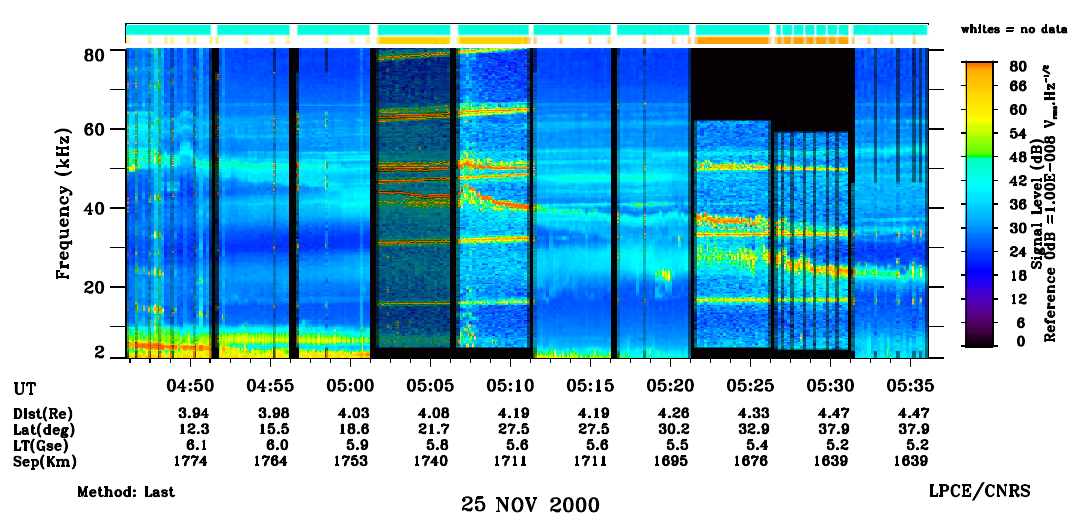
Fig. 4. Same period as in Fig. 3 but obtained from Cluster 4 Tango. Whisper was in active mode part of the time, as indicated by the yellow-orange bar at the top of the spectrogram. The strong resonance is associated with the strong decreasing